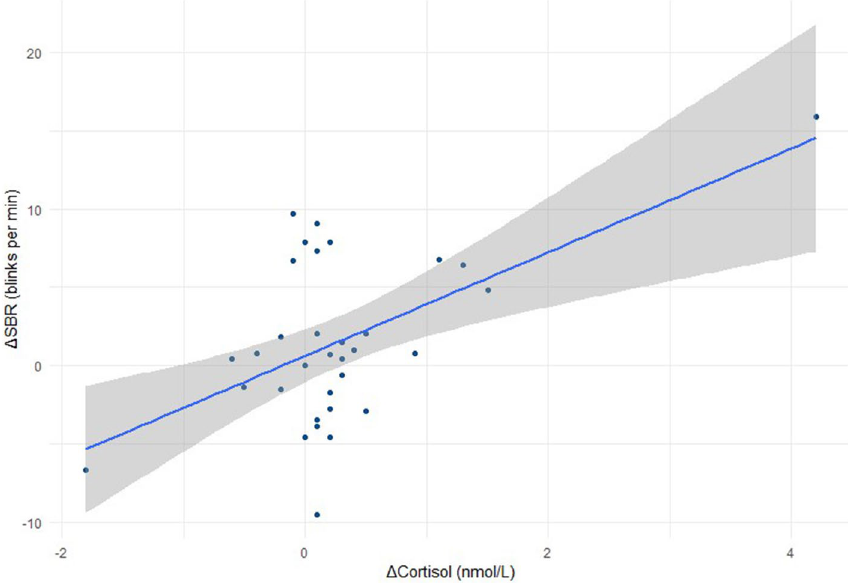
Figure 2. Correlation of SBR with Cortisol. Correlation of change in SBR (B verses CT) against change in Cortisol (B verses CT) for all horses (low and high reactive; n = 33) (r = 0.56, p < 0.001).